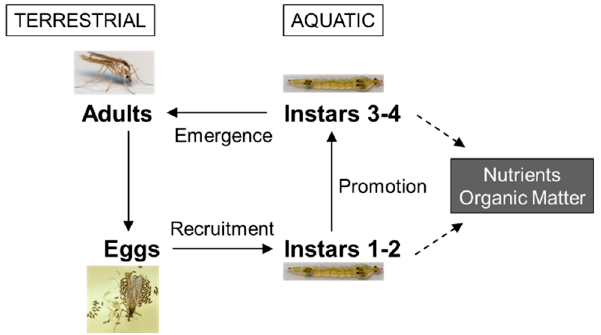
Figure 3. Simplified framework of the ecosystem model built in WEST with AQUATOX equations (full arrow: consumption terms; dashed arrow: loss terms). Extension of Figure 2 in Clouzot and Vanrolleghem [12].